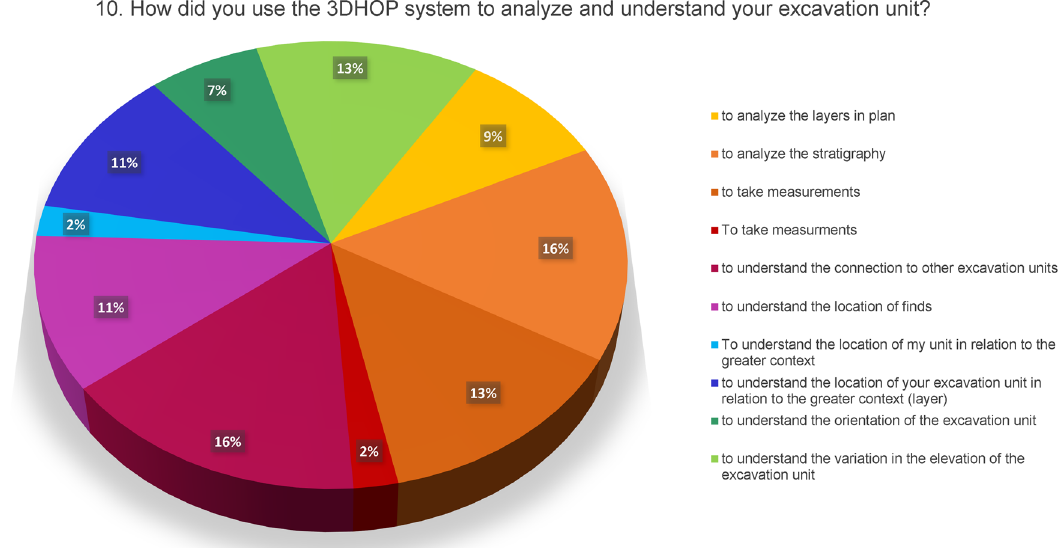
Figure 8: Question 10 illustrates its use in analysis and understanding of the excavation unit.